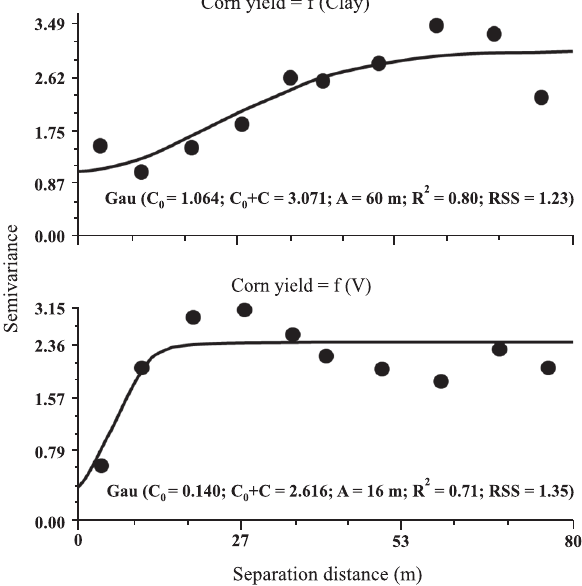
Figure 4. Cross semivariogram between corn yield and clay content (a) and V (b). V: percentage of soil base saturation; gau: gaussian; C 0 : nugget effect; C 0 +C: sill; a: range; RSS: residual sums of